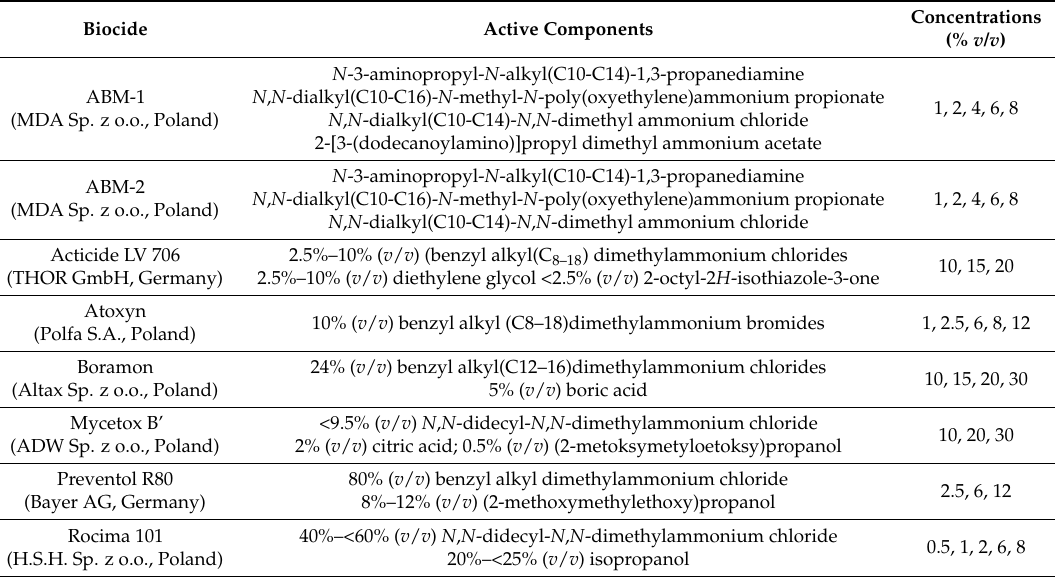
Table 5. Biocides used in the